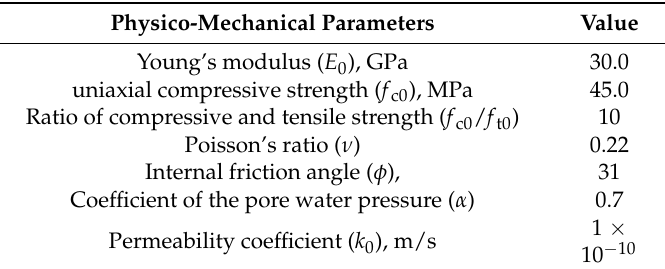
Figure 6. The numerical model. Table 1. Physico-mechanical